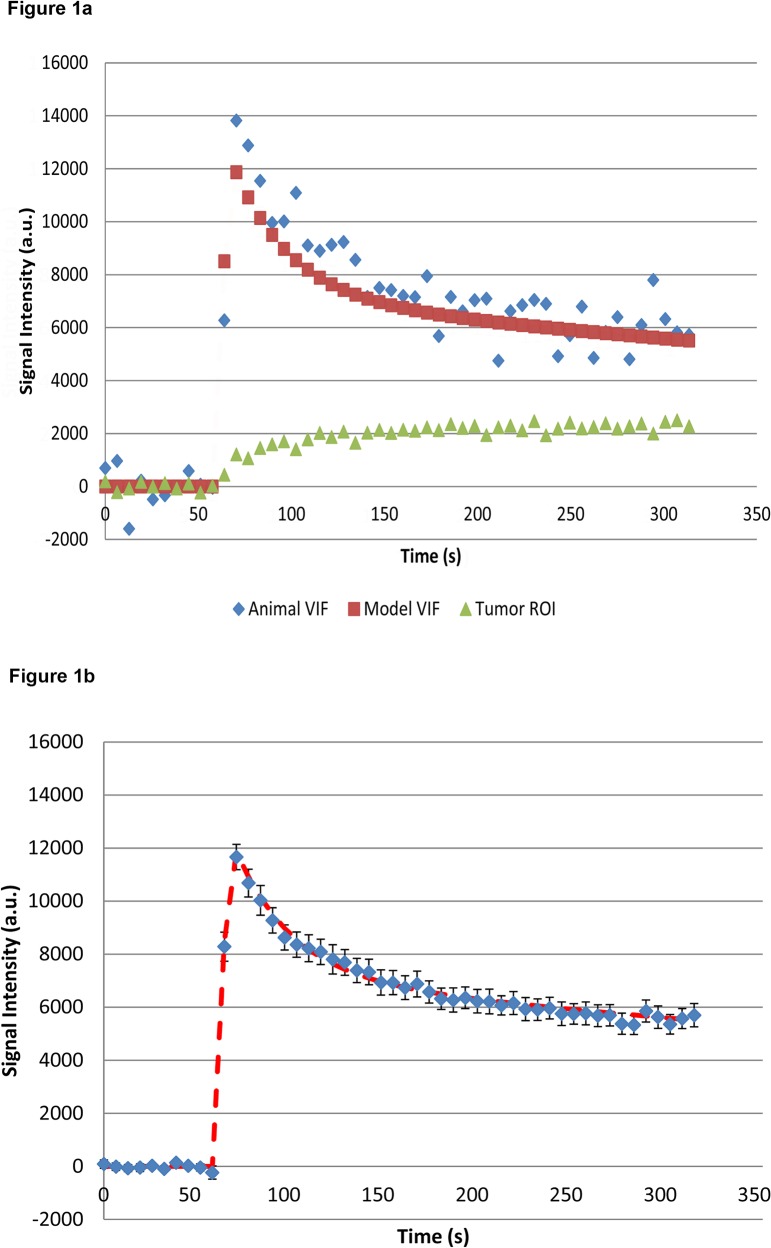
Example of signal intensity profiles.A) Vascular input function (VIF) from a representative individual animal (blue), and population average (red). Green symbols: tumor whole ROI data. Y-axis in units of signal intensity change from baseline, ΔSI. B) Average signal intensity change (VIF) from all animals and scan visits, including the standard error, for each data point (blue); and the fitted population-average VIF curve (red line). Y-axis in units of signal intensity change from baseline, ΔSI.